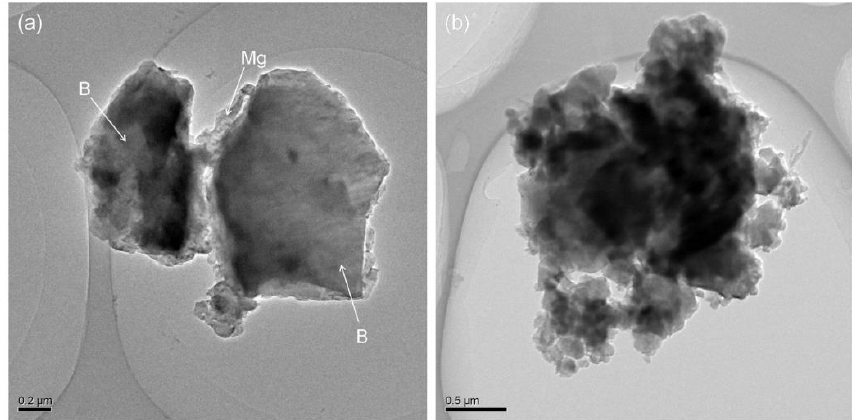
Figure 9. TEM images of ( a ) Mg/B2 cryomilled for 6 h, ( b ) and Mg/B2 cryomilled for 9 h.